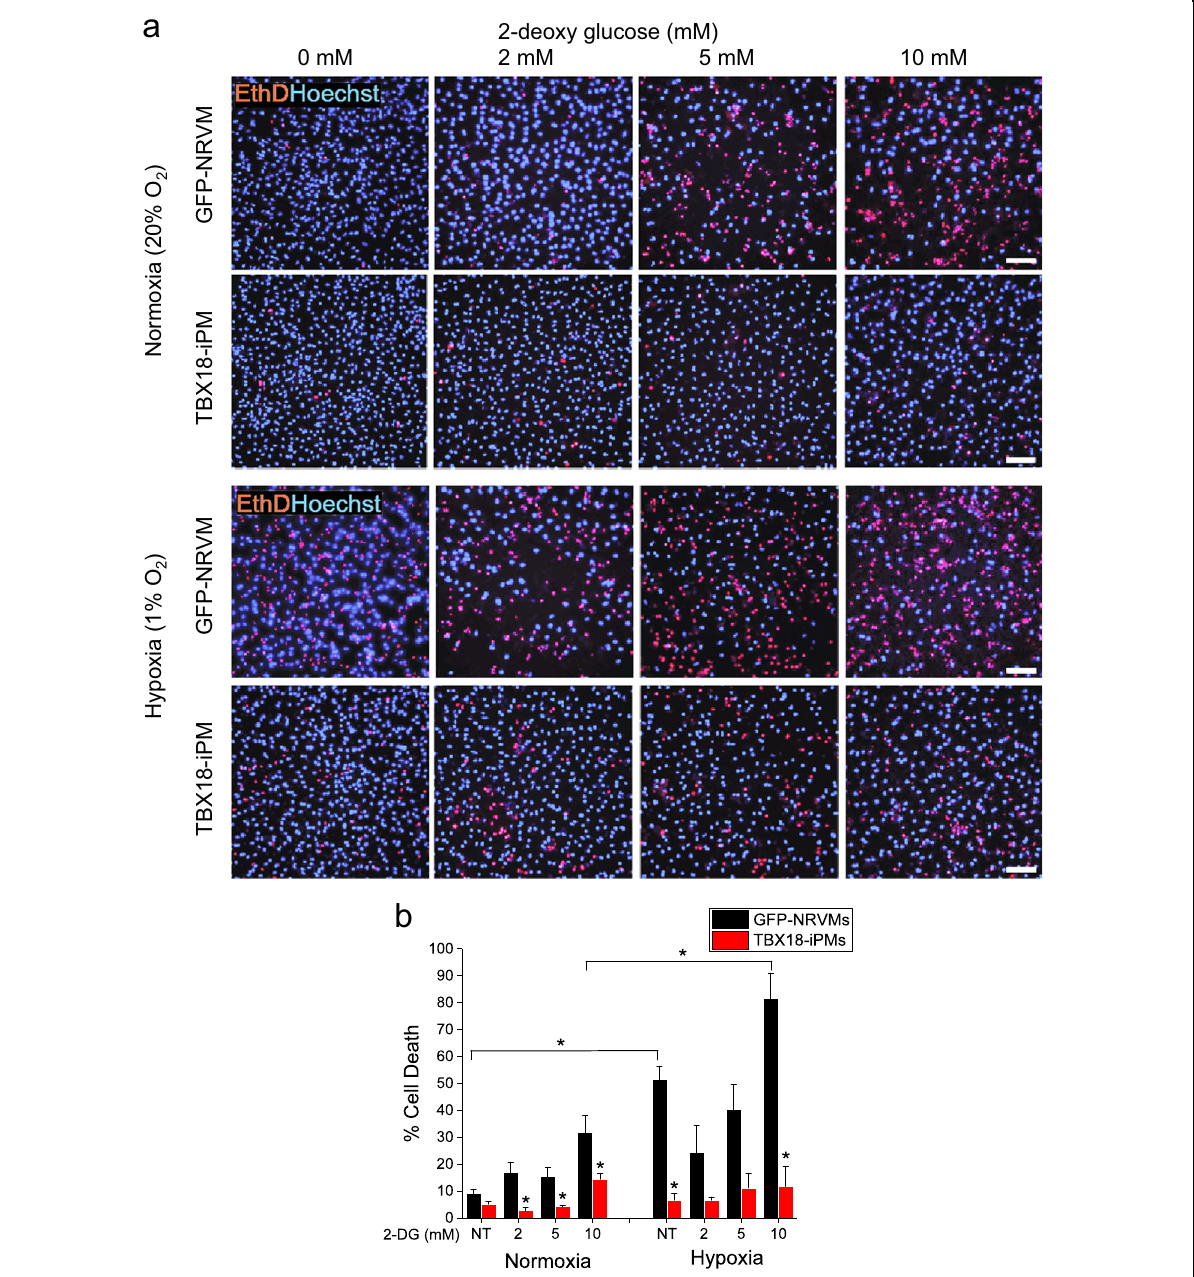
Fig. 1 Higher resistance of TBX18-iPMs to metabolic stresses. a TBX18- and GFP-NRVMs were incubated in normoxia or 1% oxygen (Hypoxia) with or without 2-DG treatment for 3 days from D3 to D6, followed by ethidium homodimer-1 (EthD-1) staining on D6. The % cell death was calculated based on the number of EthD-1 + cells per total cells. Representative pictures of EthD-1 and Hoechst 33342 staining of D6 GFP- and TBX18- NRVMs. b Quantitative graphs of % cell death ( n ≥ 8 for each condition). Scale bar: 10 µm * p <